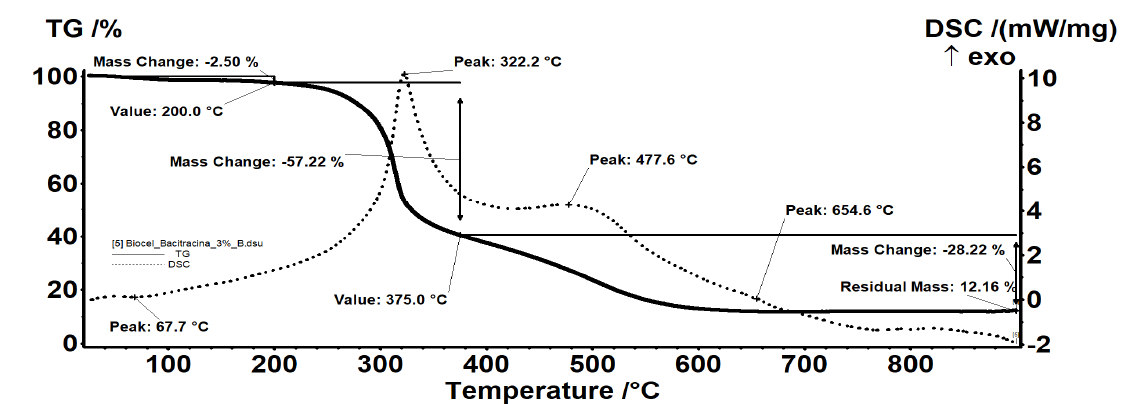
Figure 5. Thermal analysis of BC-bacitracin 3%.